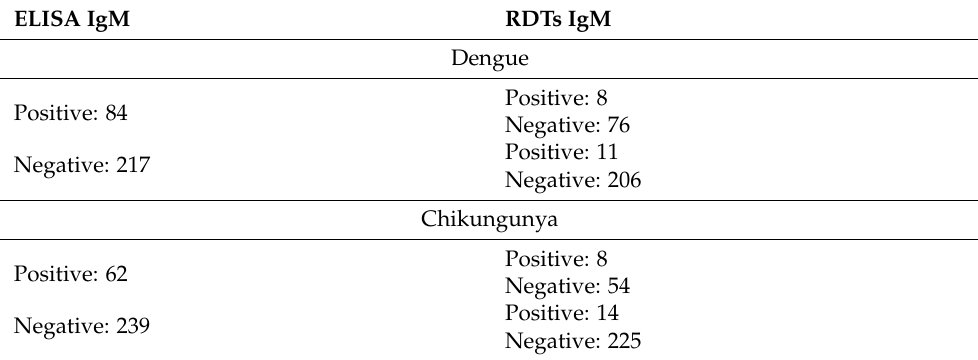
Table 6. Results of ELISA crossed with those of RDTs for dengue and chikungunya early marker (IgM) detection.